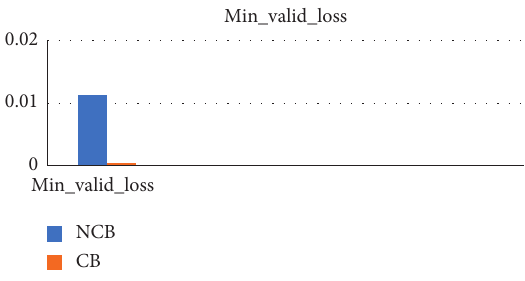
Figure 10: Comparison of minimum verification